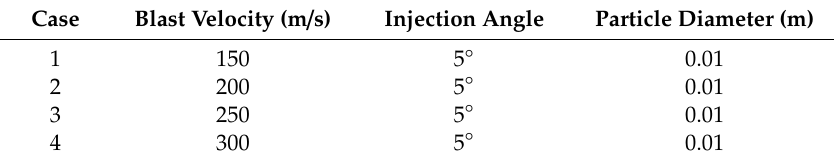
Table 4. Computational conditions.